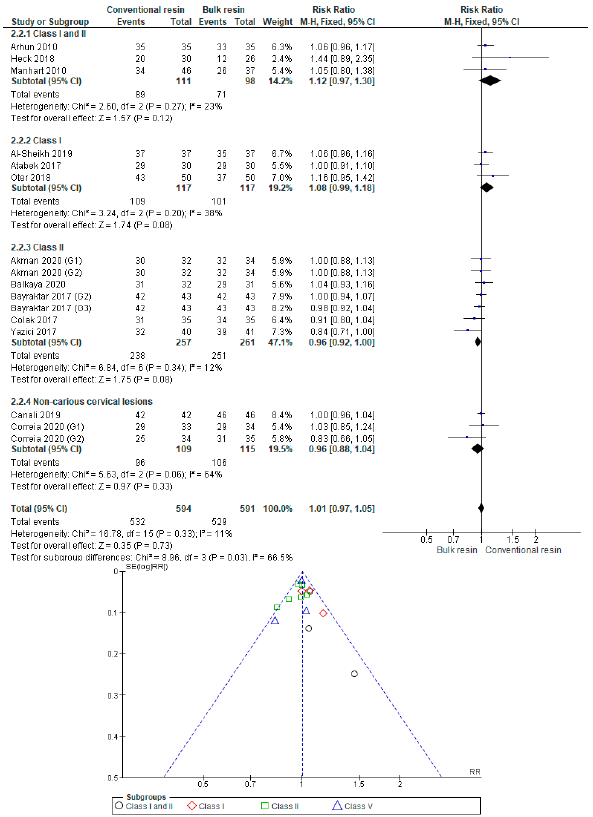
Figure A7. Absence of Discoloration or Marginal Staining: Conventional Resin versus Bulk Resin According to Type of Restoration.